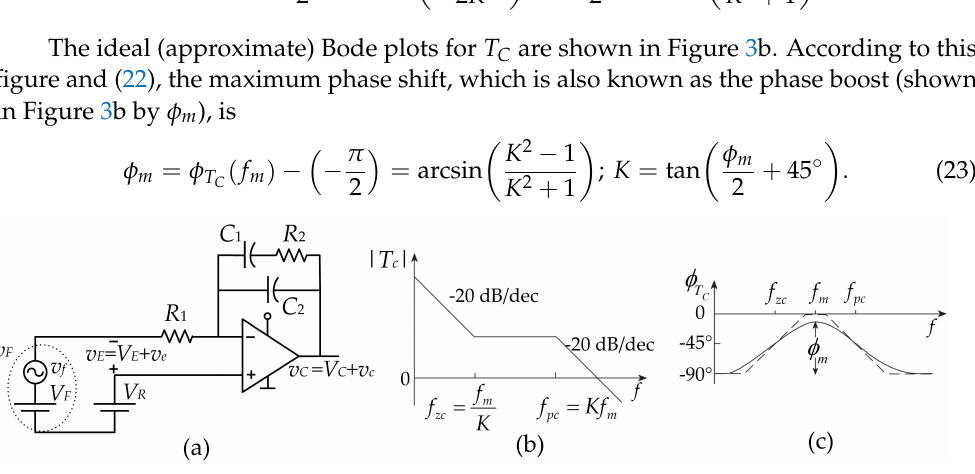
Figure 3. ISLC, ( a ) analog implementation, ( b ) amplitude, and ( c ) phase of ideal Bode plots